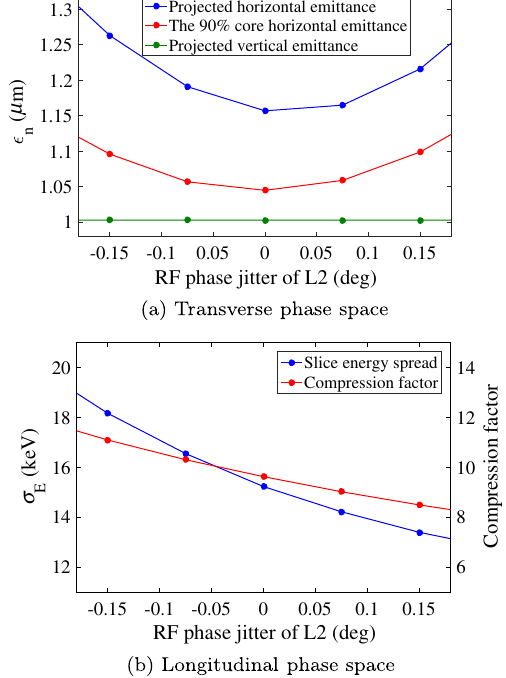
FIG. 7. The effects of the rf phase jitter on the electron beam in the system. (a) Normalized projected emittances in transverse phase space, (b) slice energy spread and compression factor in longitudinal phase